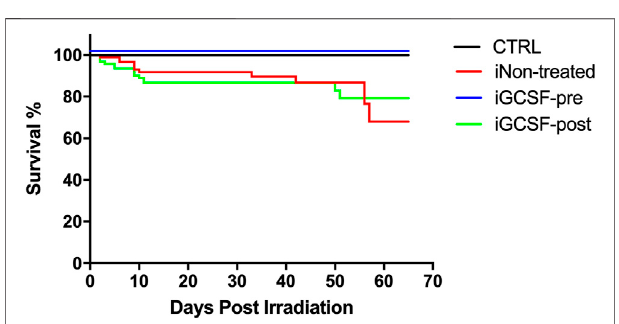
FIGURE 10 | Survival analysis. Kaplan – Meier curves of survival for 60- day post-irradiation in the CTRL, iNon-treated, iGCSF-pre and iGCSF-post Group ( n (cid:1) 20 per Group). The survival is statistically signi fi cant in a log-rank (Mantel-Cox) test, where the comparison of all survival curves **** p < 0.0001;iGCSF-prevs.iGCSF - post*** p (cid:1) 0.0002;iGCSF-prevs.iNon-treated *** p (cid:1) 0.0005 and iGCSF - post vs. iNon-treated p (cid:1) 0.6929.